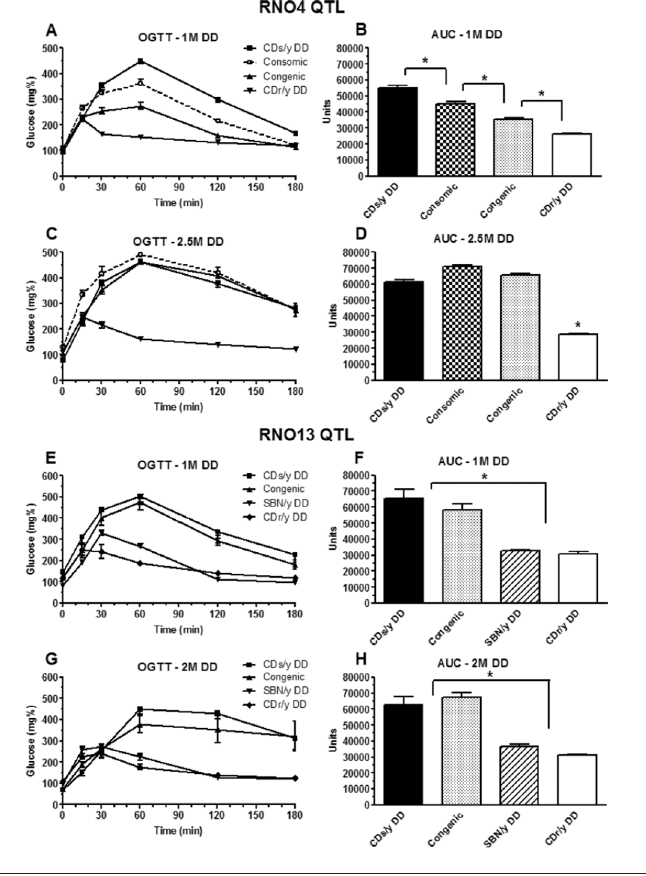
Figure 5. Results of the OGTT after 1 and 2.5 or 2 months of DD in consomic/congenic strains and their respective controls. The left panels (A and C) represent average blood glucose levels at set times of the OGTT (mean ± standard error of the mean). The right panels (B, C, F and G) represent the AUC of glucose levels during the OGTT. * p < 0.01 by ANOVA and post hoc LSD testing. RNO4 QTL: CDs/y (n = 29, 19), consomic strains for RNO4 (n = 29, 7), congenic strains for the RNO4 QTL (n = 25, 5) and CDr/y (n = 10, 4). RNO13 QTL: CDs/y (n = 8,6), congenic strains for the RNO13 QTL (n = 8,7), SBN/y (n = 9,10) and CDr/y (n =